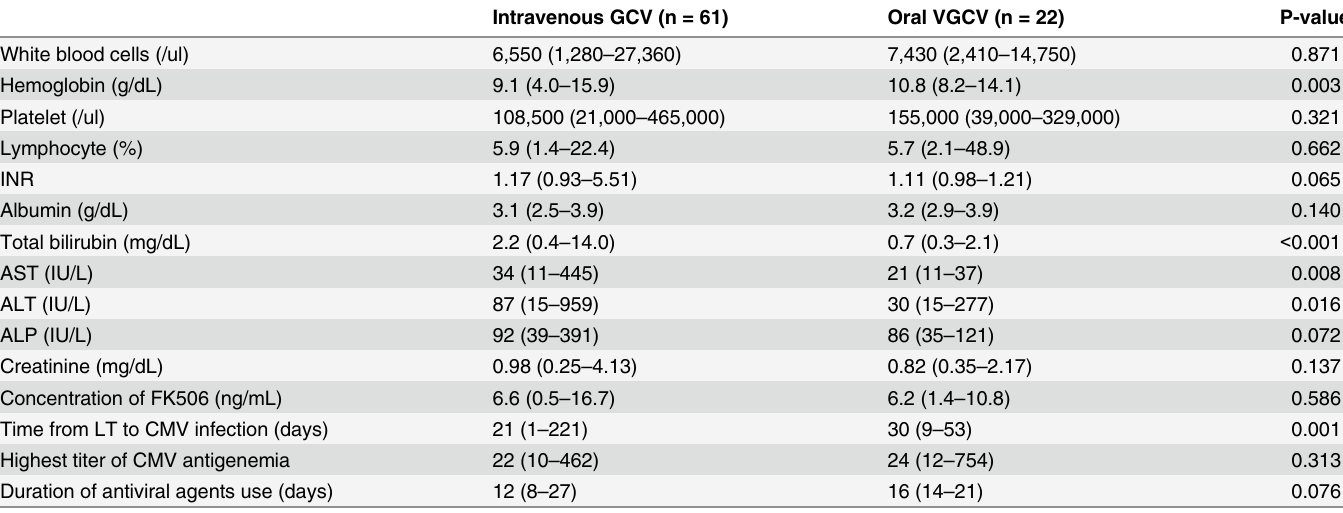
Table 3. Clinical characteristics between intravenous GCV and oral VGCV.